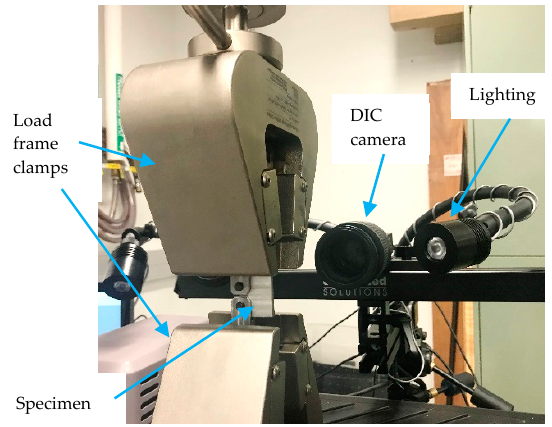
Figure 7. Testing